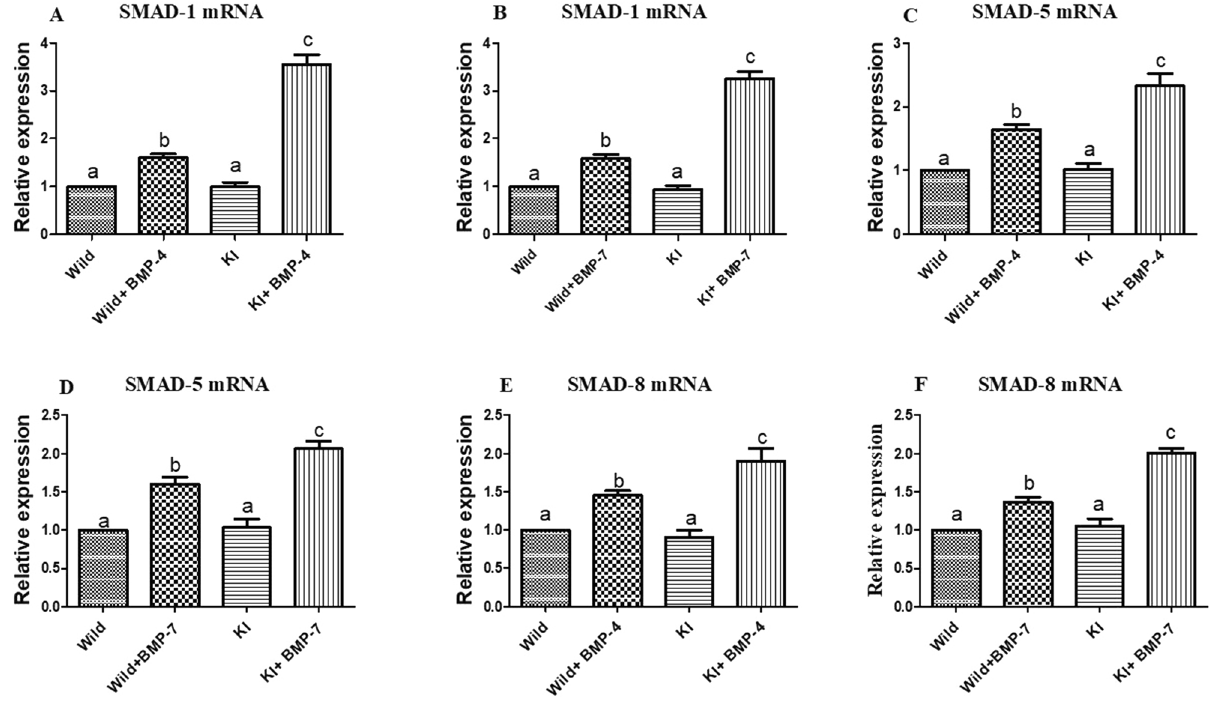
Figure 6. Effect of BMPR-IB gene KI on expression of Smad1, Smad5 and Smad 8 transcripts in in vitro cultured granulosa cells stimulated with BMP-4 (50 ng/ml) or BMP-7 (100 ng/ml) for 72 h. All values are shown as mean ± SEM. Different superscripts denote statistically different values ( p < 0.05). Abbreviations: WT indicate wild type cells, WT + BMP-4/BMP-7 indicate wild cells treated with BMP-4 (50 ng/mL), KO indicate BMPR-IB gene knock out cells. KI + BMP-4/BMP-7 indicate KI cells treated with BMP-4(50 ng/ml) or BMP-7 (100